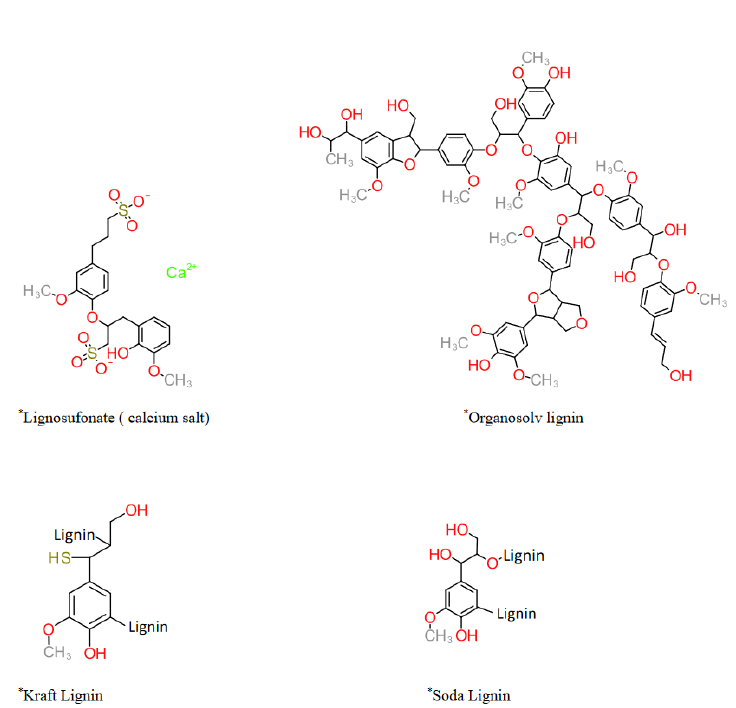
Figure 4. Common technical lignins (* simplified and representative structures).